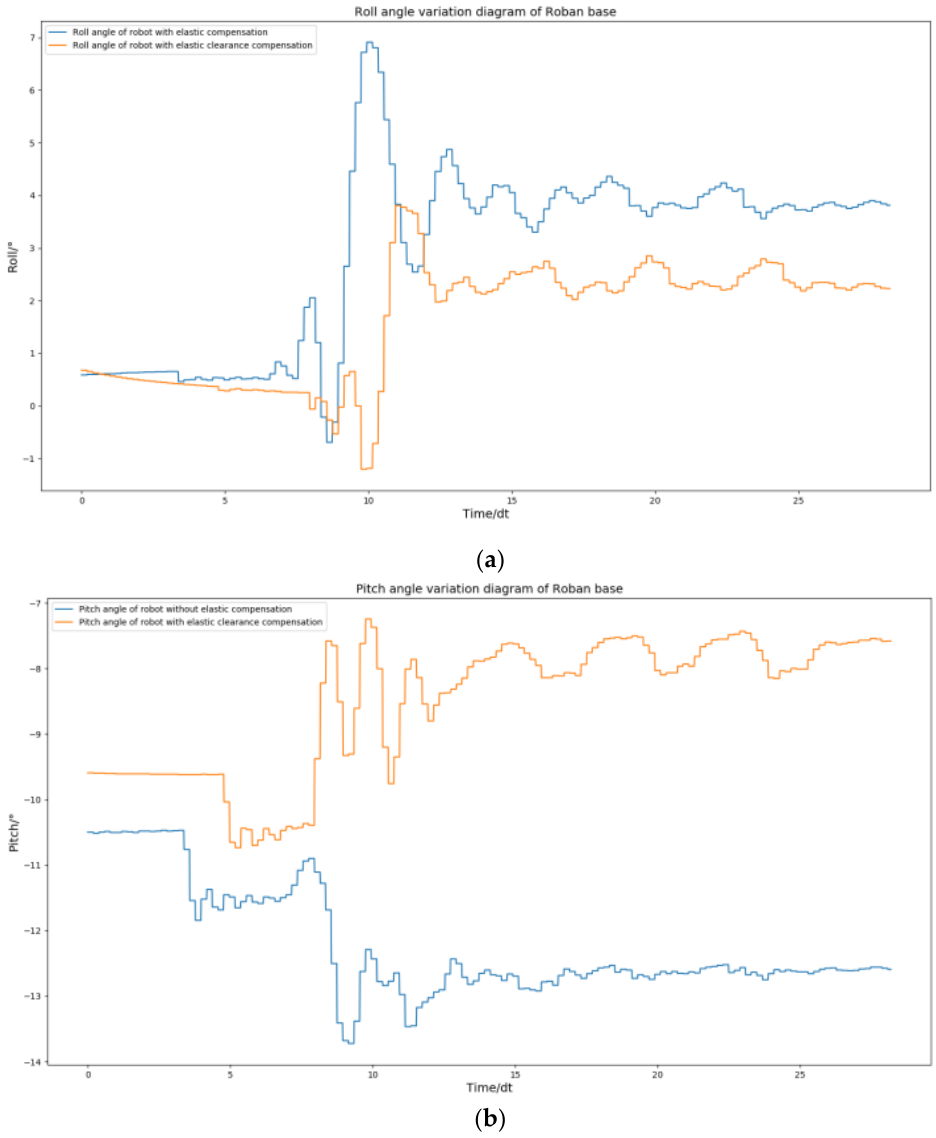
Figure 27. The Roban robot performs a side swing motion. We obtained the curve comparison dia- gram of roll angle and pitch angle of the robot with and without spring clearance compensation in this process. ( a ) Comparison diagram of roll angle change of robot with and without spring compensation. ( b ) Comparison diagram of pitch angle change of robot with and without spring com- pensa-tion.